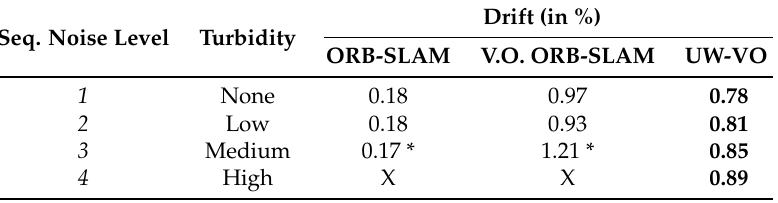
Figure 7. Drift of ORB-SLAM (green), V.O. ORB-SLAM (blue) and UW-VO (red) on the simulated underwater dataset. Table 1. Translation drift (in %) on the simulated underwater video sequence with different level of noise simulating turbidity effects. Results are given averaging over five runs for each algorithm. V.O. ORB-SLAM designates ORB-SLAM without the loop closing feature enabled, i.e., performing only Visual Odometry. ORB-SLAM results are given for information. The (*) denotes very frequent failure of the